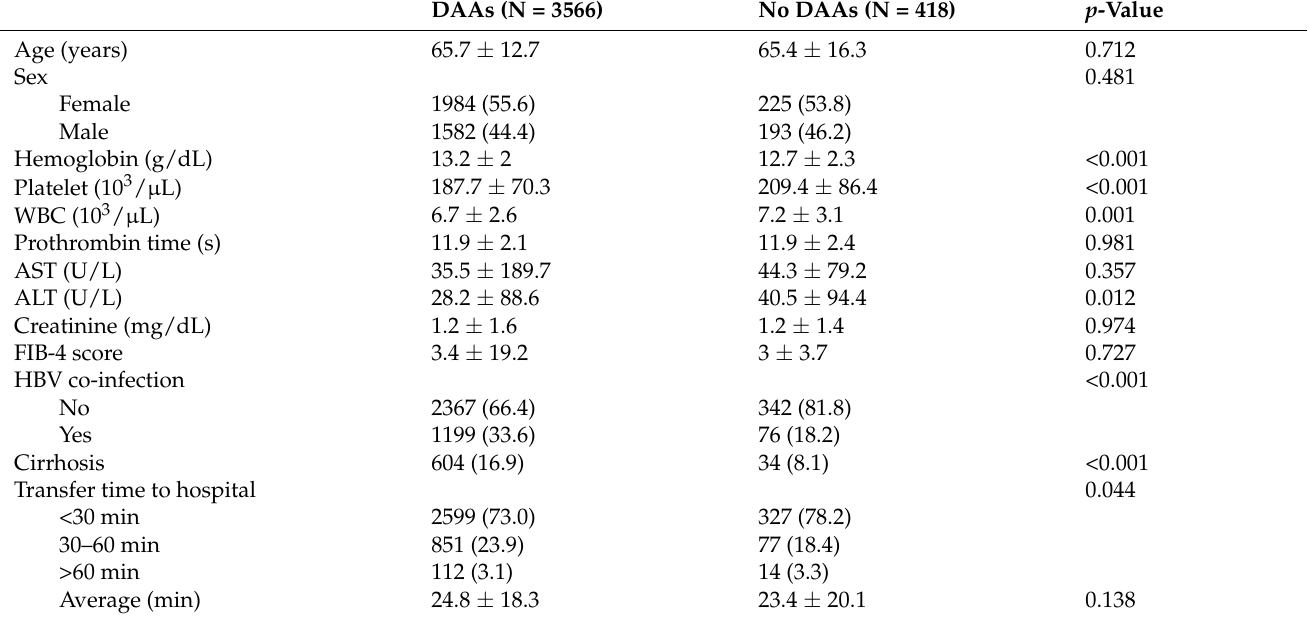
Table 1. Characteristics of patients with hepatitis C infection who have and have not received treatment. DAAs (N =